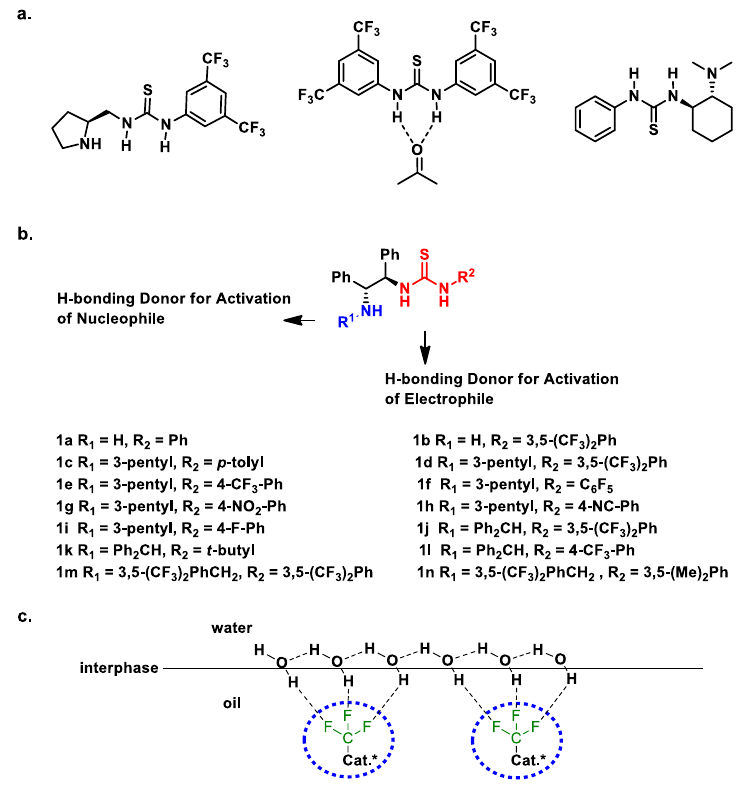
Figure 1. Non-covalent organic catalysts in aqueous media. ( a ). Chiral, achiral hydrogen-bonding catalysts are widely used for asymmetric reactions. ( b ). Thiourea catalyzes several reactions by forming hydrogen bonds with the substrate. ( c ). Chiral hydrogen-bonding catalysts used for asymmetric C–C Michael reactions.